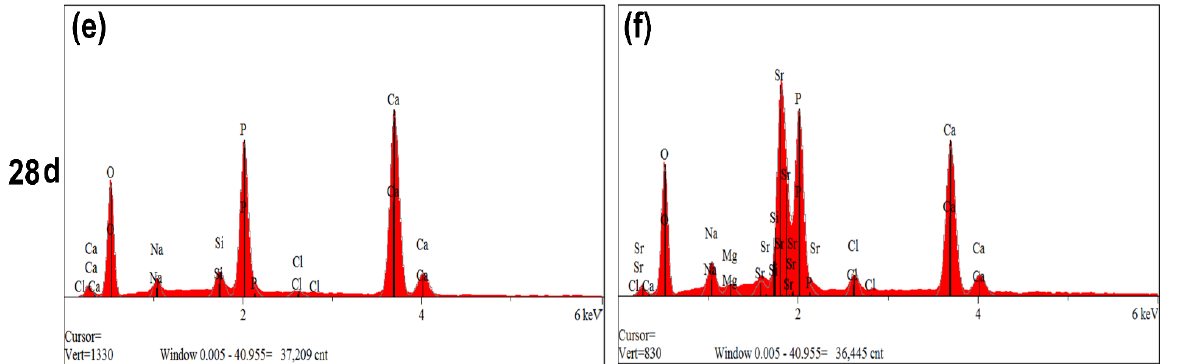
Figure 4. EDX spectra of Ca and P in CS after immersion in PBS for 1 d ( a ), 7 d ( c ), and 28 d ( e ) demonstrate gradual increase in P peak, indicating the formation of apatite-like crystals. Figure 4 ( b , d , f ) show EDX spectra of Ca and P in CSR which also demonstrated gradual increase in P peak as an indicator for apatite crystals deposition. Sr peak was detected in CSR only. Figure 5 shows the FTIR spectra of CS (a) and CSR (b) after 28 d of immersion in PBS. For CS, the bands at 561 cm − 1 , 601 cm − 1 , and 1023 cm − 1 correspond to the PO 43 − group. The peaks at 872 cm − 1 and 1416 cm − 1 correspond to the CO 32 − group. For CSR, the split band at 567 cm − 1 corresponds to the PO 43 − group. The peaks at 871 cm − 1 and 1411 cm − 1 correspond to CO 32 − group. These are characteristic bands indicating hydroxyapatite (HAP) crystal formation.